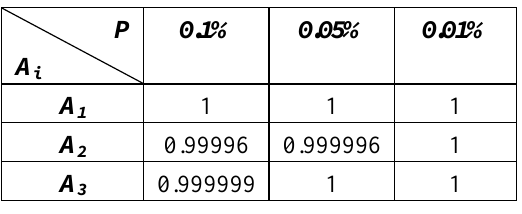
Table 2. Network Availability of i link failures: A